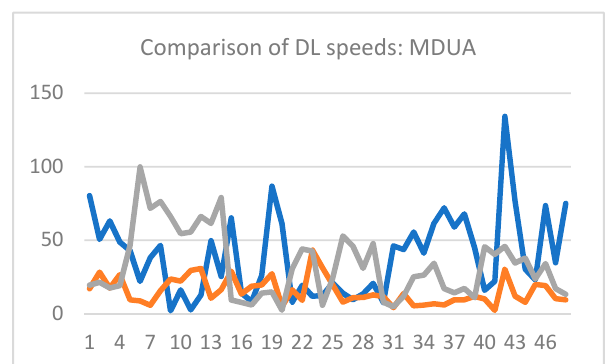
Figure A1. Comparison of DL speeds: MDUA.